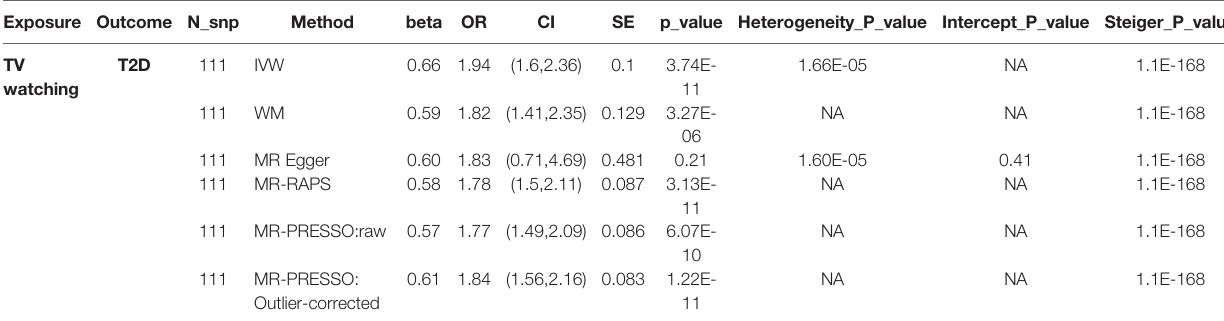
TABLE 3 | The association between TV watching and risk of type 2 diabetes after remove 16 SNPs associated with confounding traits. Exposure Outcome